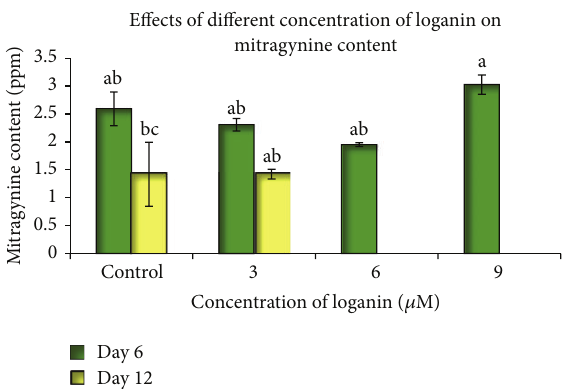
Figure 8: The effect of different loganin concentrations at different culture times on the mitragynine content in the suspension cultures of Mitragyna speciosa . The bars indicate standard error. ∗ Values with the same letters are not significantly different according to Duncan’s multiple range